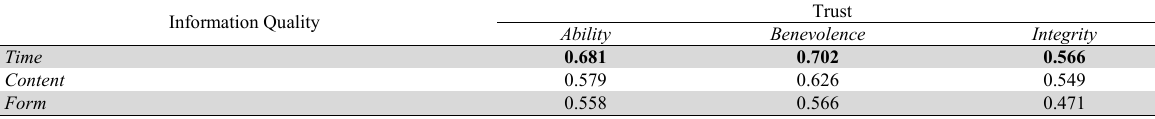
Correlation between Dimensions of Information Quality and